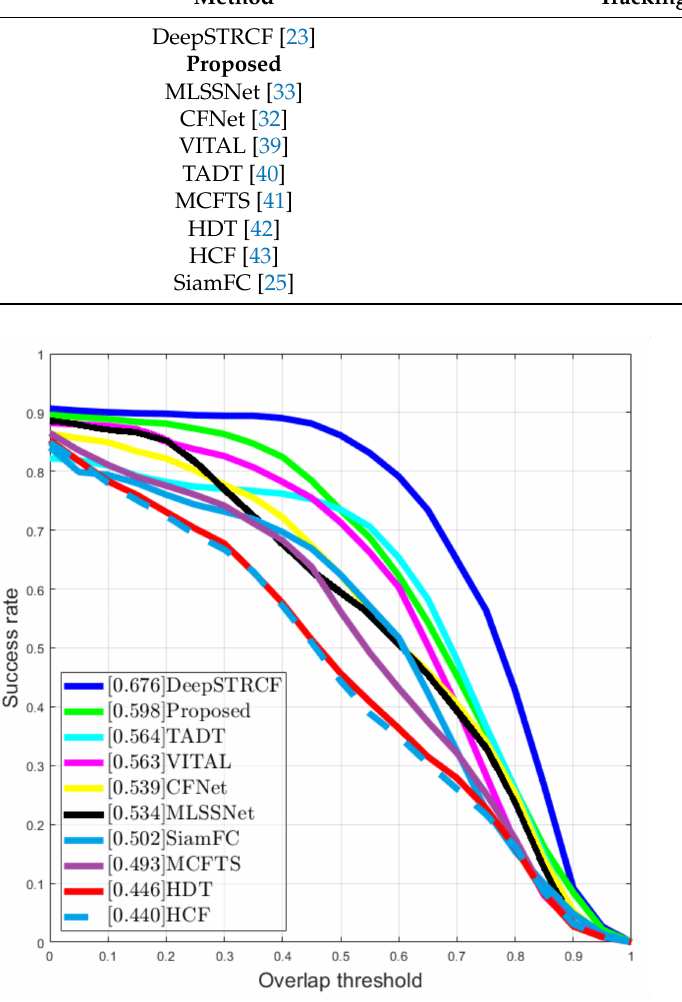
Figure 10. Plot that measures the overlapping score between the tracked object and ground.